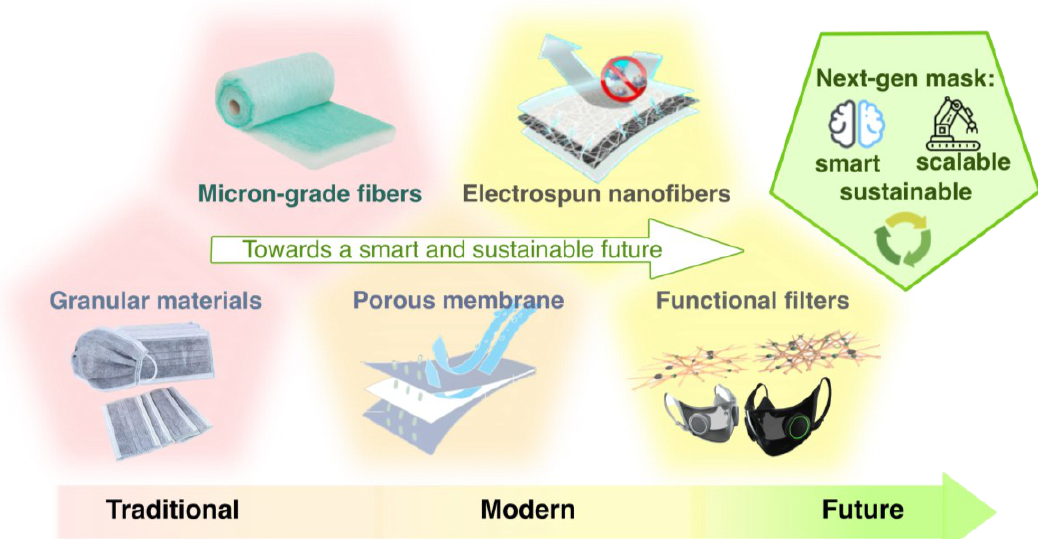
Figure 3. Mask filtration material development: a trend to higher porosity and improved filtration efficiency.